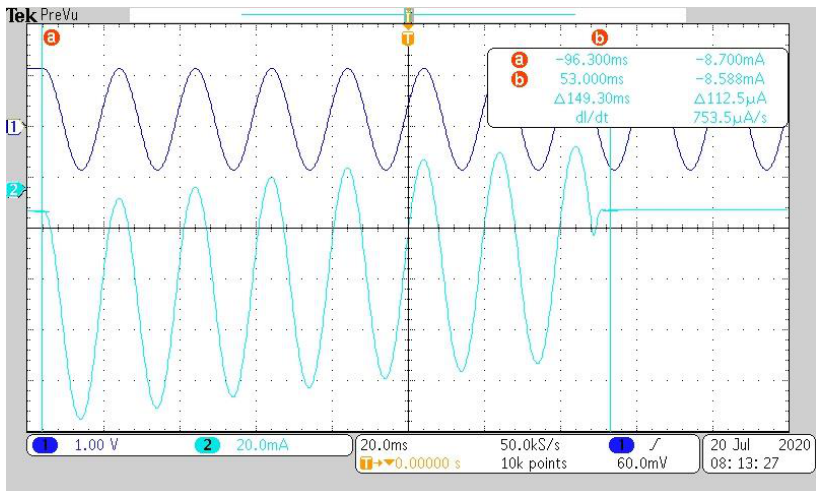
Figure 14. Supply voltage (channel 1) and disconnection current (channel 2) vs. time for RCD-8, with an input of 30 mA (50 Hz), initial phase of 90°, and measured break time of 149 ms.